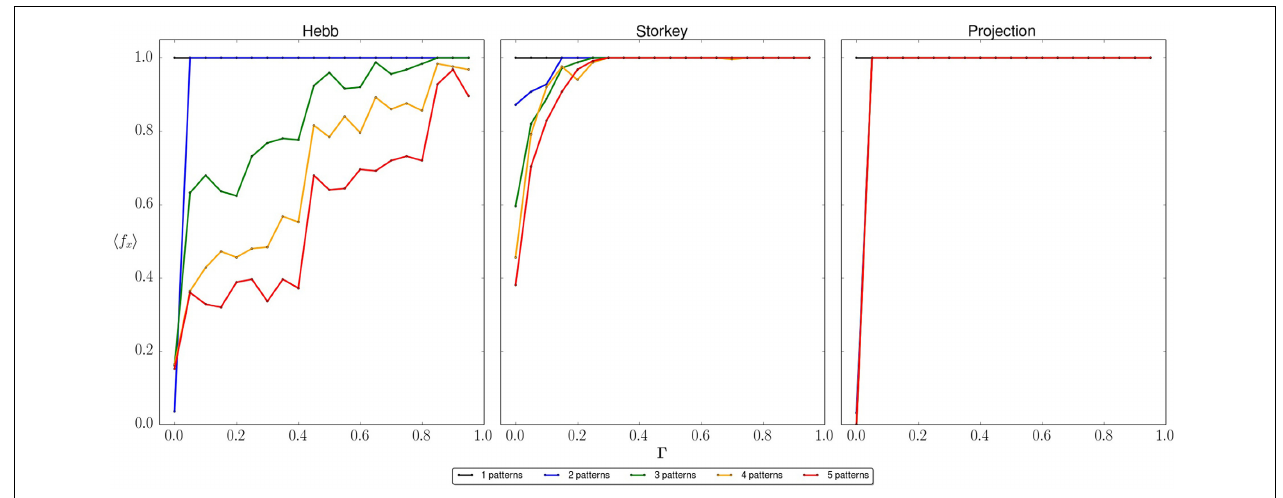
FIGURE 7 | Average probability to recall the correct memory with respect to applied bias. The average is taken over an ensemble of network instances with n = 5 neurons and p = 1 , 2 , 3 , 4, or 5 stored